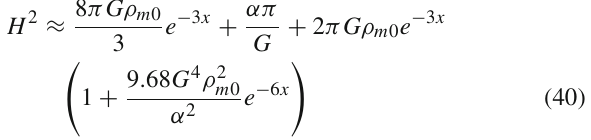
wherethefractionalenergydensity (cid:15) m 0 = 8 π G ρ m 0 is used. The deceleration parameter defined such as